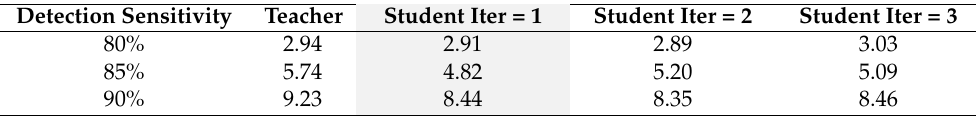
Figure 9. The impact of student model training iterations on the AFP metric. The student model performances for ( a ) single training iteration (default setup), ( b ) two iterations, ( c ) three iterations, and ( d ) comparisons between the teacher and student models with these setups are presented. Table 4. AFP vs sensitivity for different student model iterations.